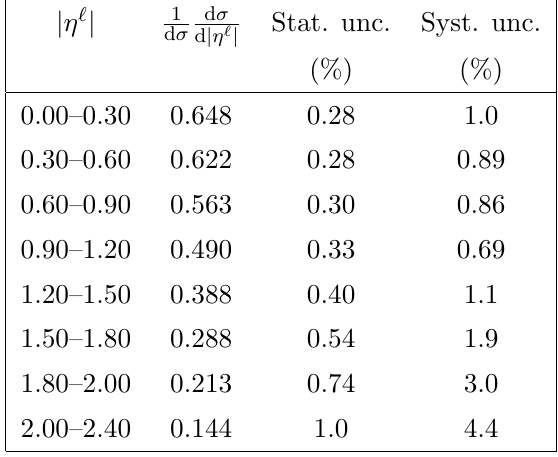
Table 10 . Results of the normalised di(cid:11)erential cross sections with relative uncertainties in the combined channel with respect to